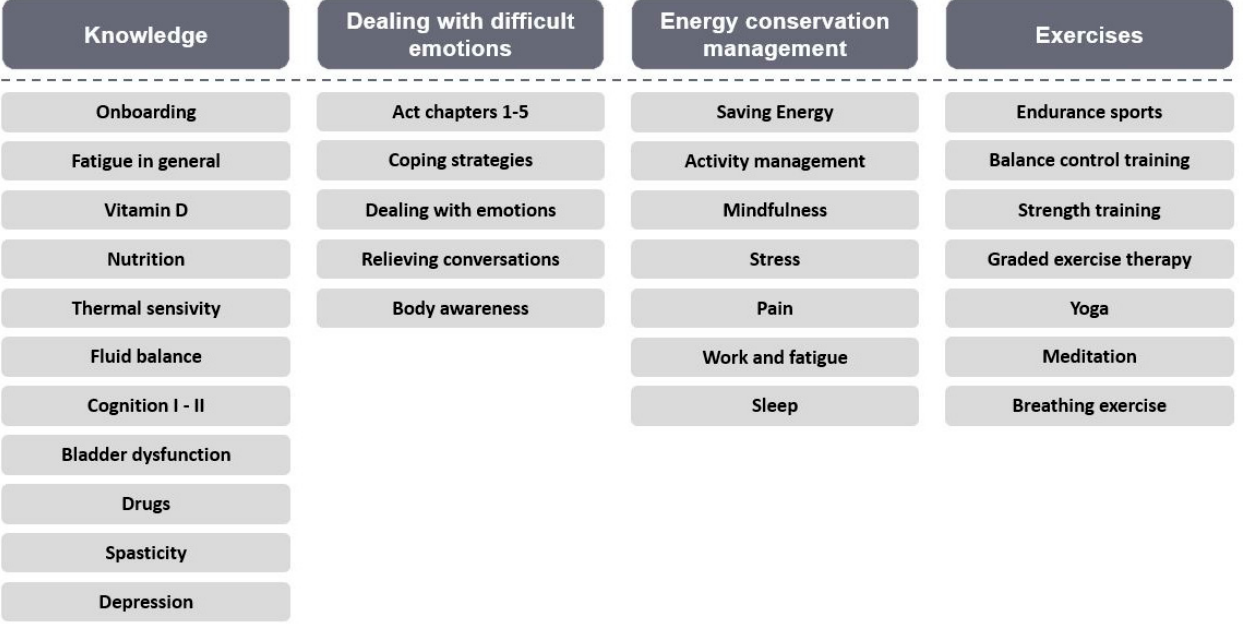
Figure 2. Overview of the Fimo fatigue course.